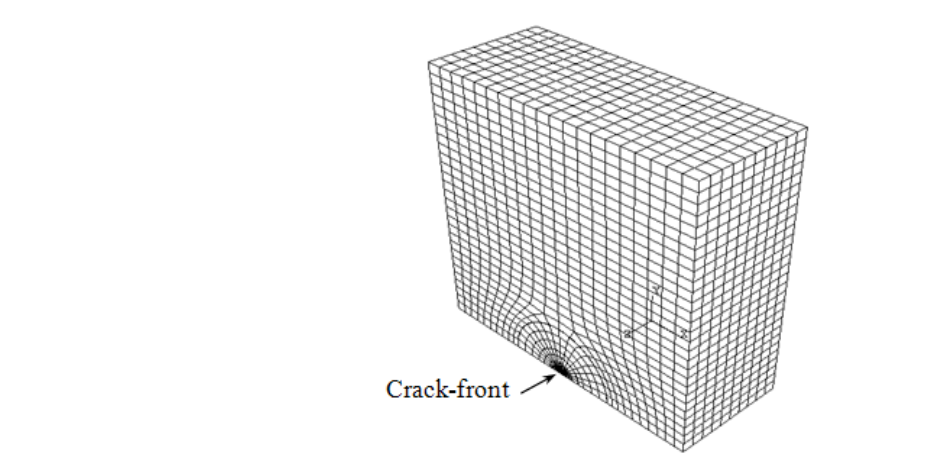
Figure 3: A typical Finite element mesh used in the analysis.